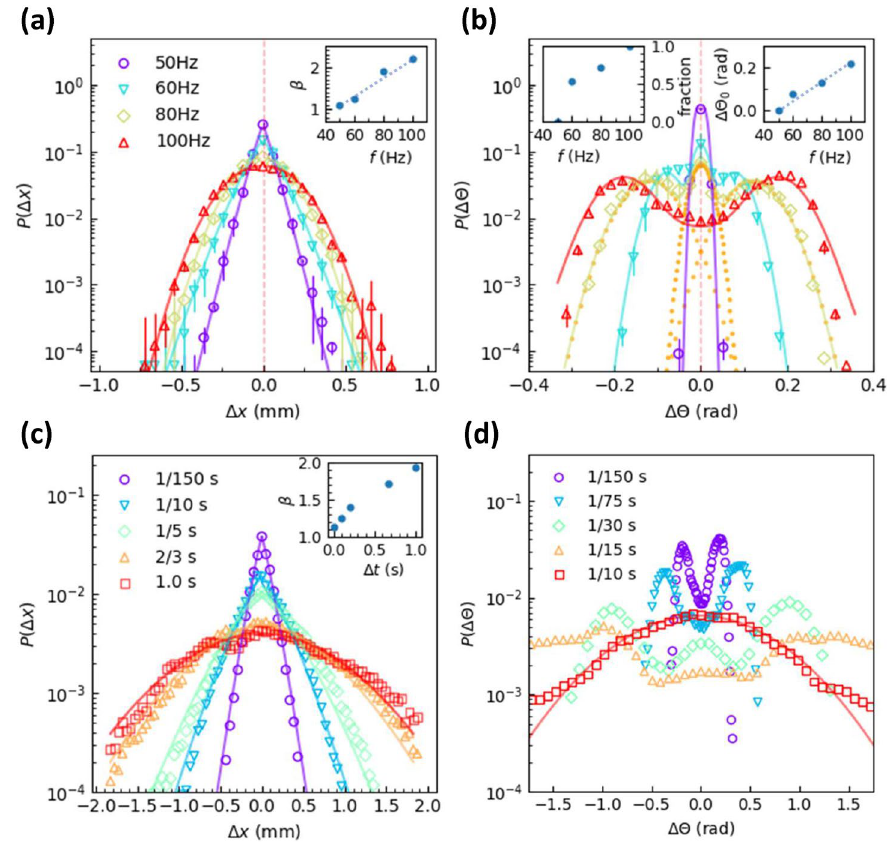
0.6 mm and 1 / 150 s at A = = 6.0, 8.7, 15.5 , and 24.0 respectively. The angular = Ae − Bx β (curves) with the β shown in = 0 and two Gaussian functions peaking = 1 / 150 s, = 1 / 150 s, 1/75 s, 1/30 s, 1/15 s, and 1/10 s =